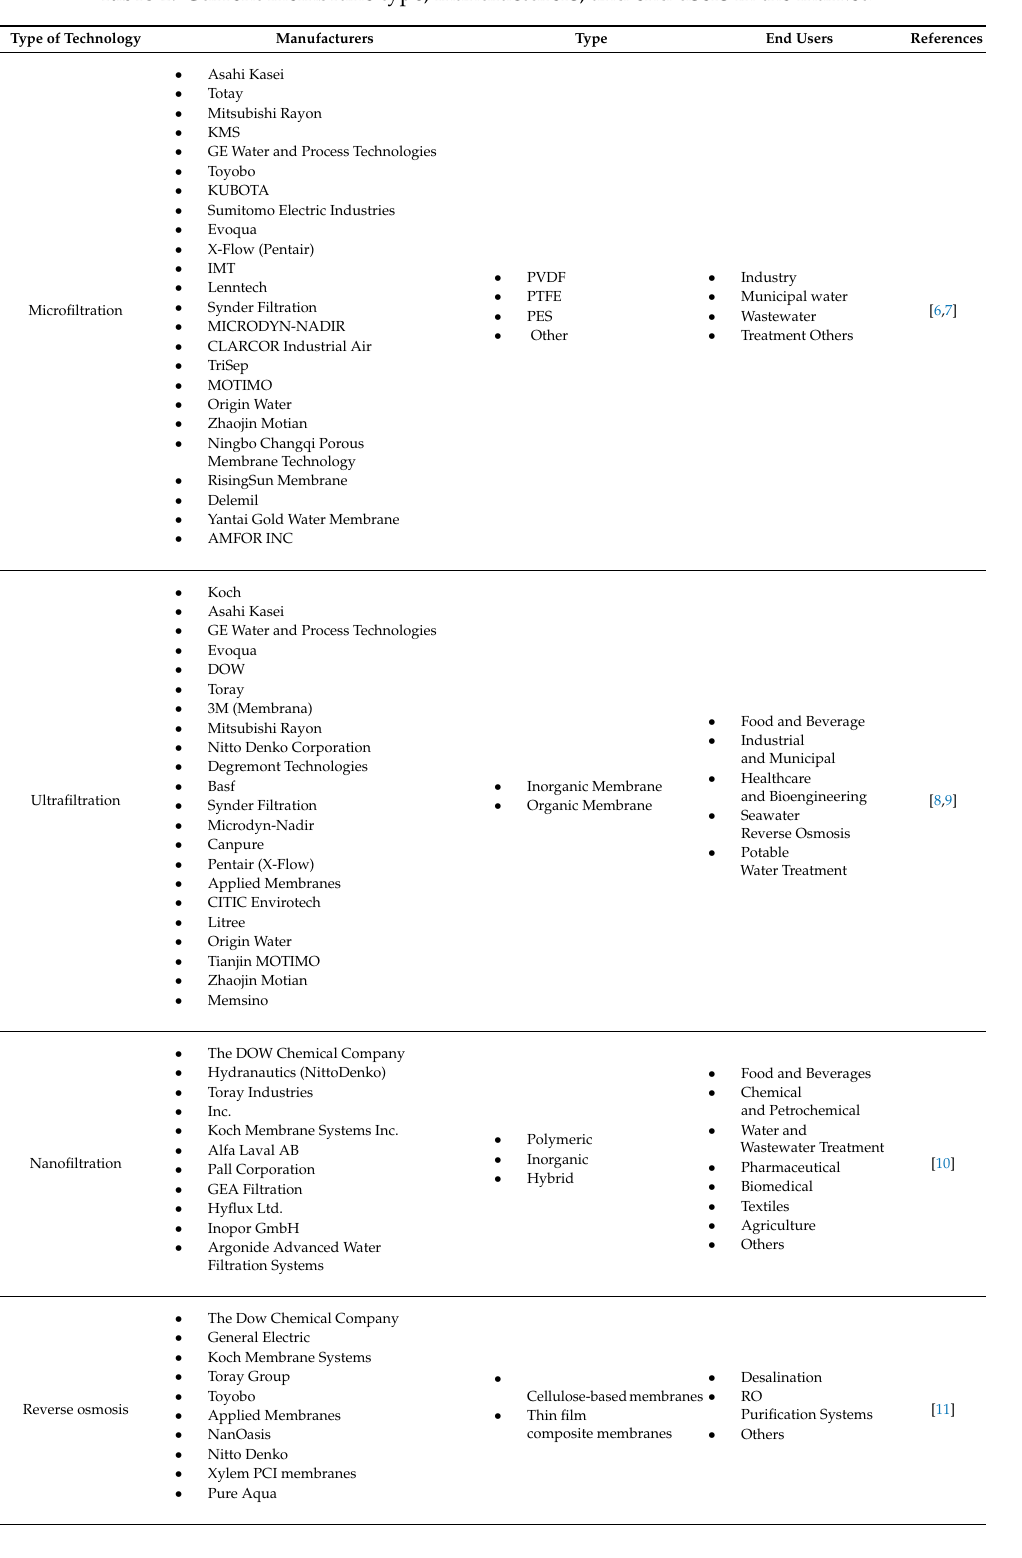
Table 1. Current membrane type, manufacturers, and end users in the